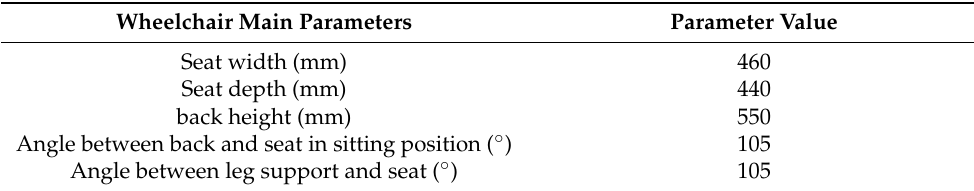
Table 2. Basic parameters of toilet wheelchair.